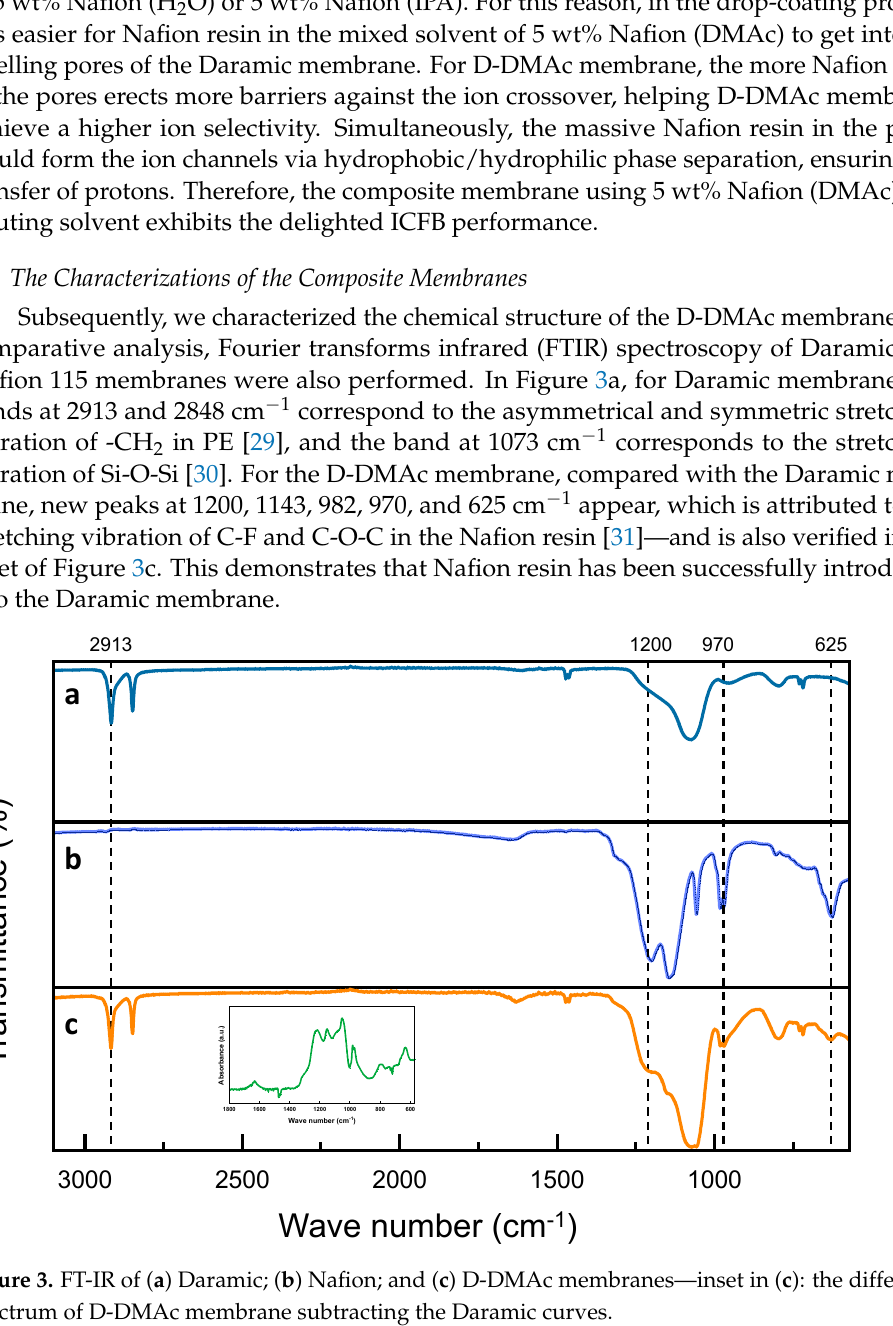
Figure 4. The ( a ) surface and ( b ) cross ‐ sectional SEM images of Daramic; the ( c ) surface and ( d , e ) cross ‐ sectional SEM images of the D ‐ DMAc membrane; ( f ) EDS mapping results of the D ‐ DMAc membrane. Combining the EDS mapping (Figure 4f) results, the Nafion resin (characteristic flu ‐ orine element) is observed on the surface and cross ‐ section of D ‐ DMAc. These above re ‐ sults demonstrate that Nafion resin successfully filled in the pores of the Daramic mem ‐ brane via the simple drop ‐ coating method. The transmission electron microscopy (TEM) images are shown in Figure 5a. The D ‐ DMAc membrane was dyed with AgNO 3 before TEM tests to replace H + in Nafion resin with Ag + . The regions with dark dots correspond to the distribution of silver ions (Ag + ), that is, the sulfonated groups in Nafion resin. Hydrophobic segments of the polymeriza ‐ tion backbone are bright regions, while clusters of hydrophilic ions of the polymer are dark. We can clearly see that the hydrophilic sulfonic acid groups are evenly dispersed in